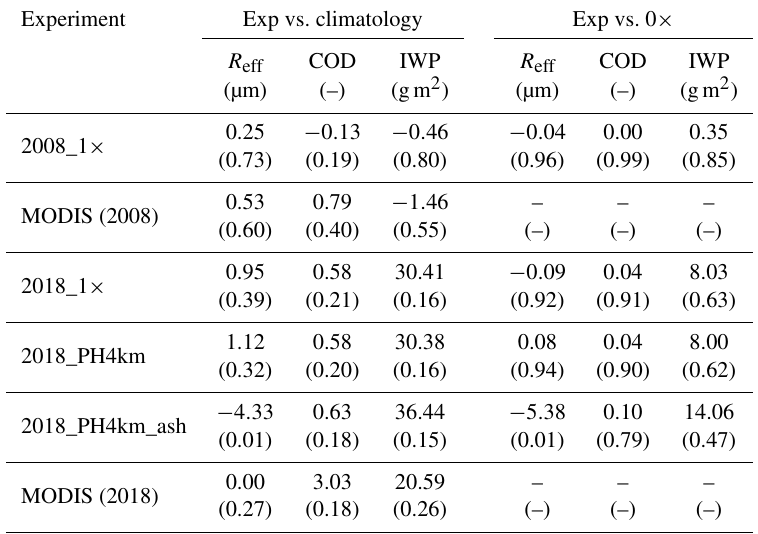
Table 5. Anomalies for ice cloud properties. Values in parentheses are the p values associated with a one-sided Student’s t test against the long-term mean.